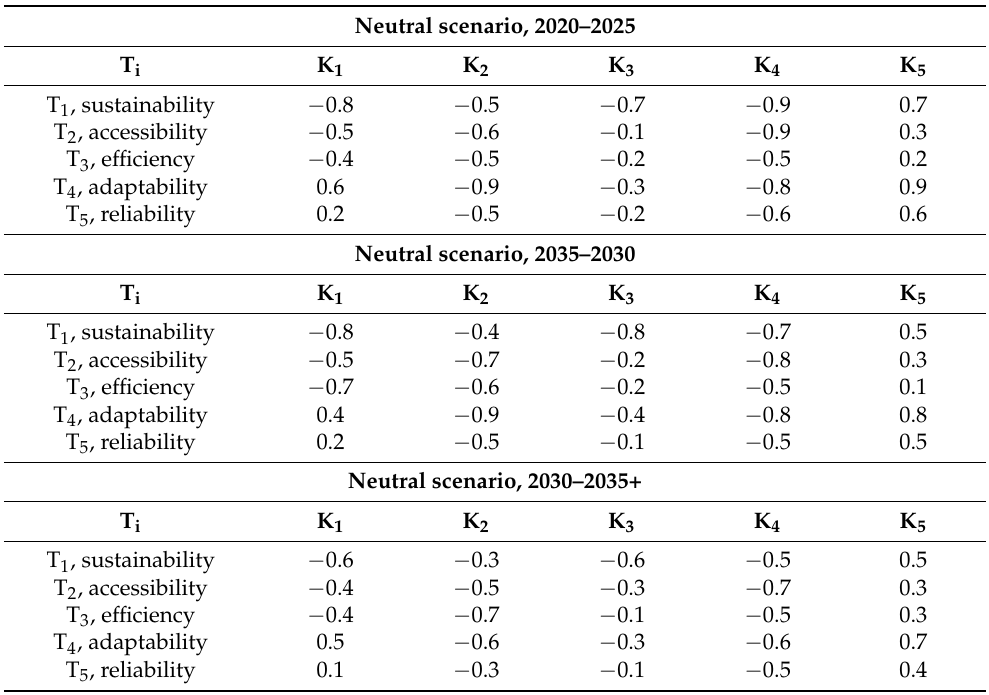
Table 2. Assessment of the properties through scenario criteria for neutral